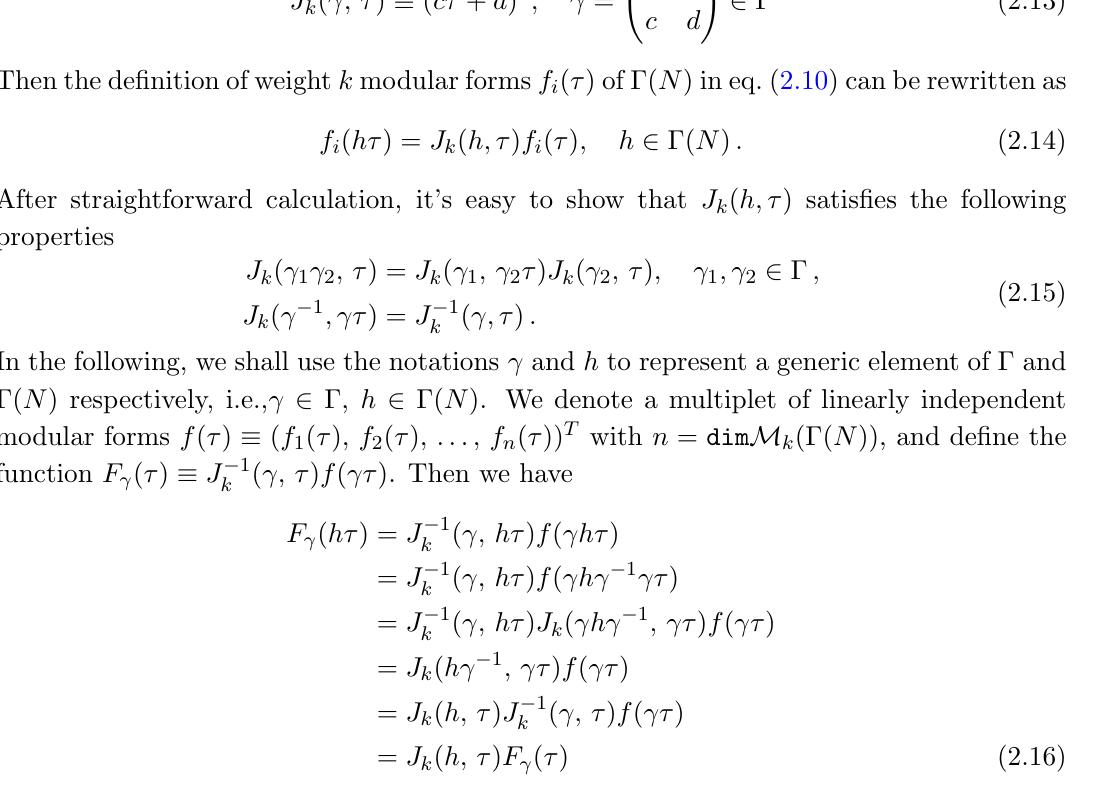
is isomorphic to the T 0 group, we denote (cid:0) 0 3 and A 0 in the computer algebra program GAP [38] are [24 ; 3], [48 ; 30] and [120 ; 5] 4 5